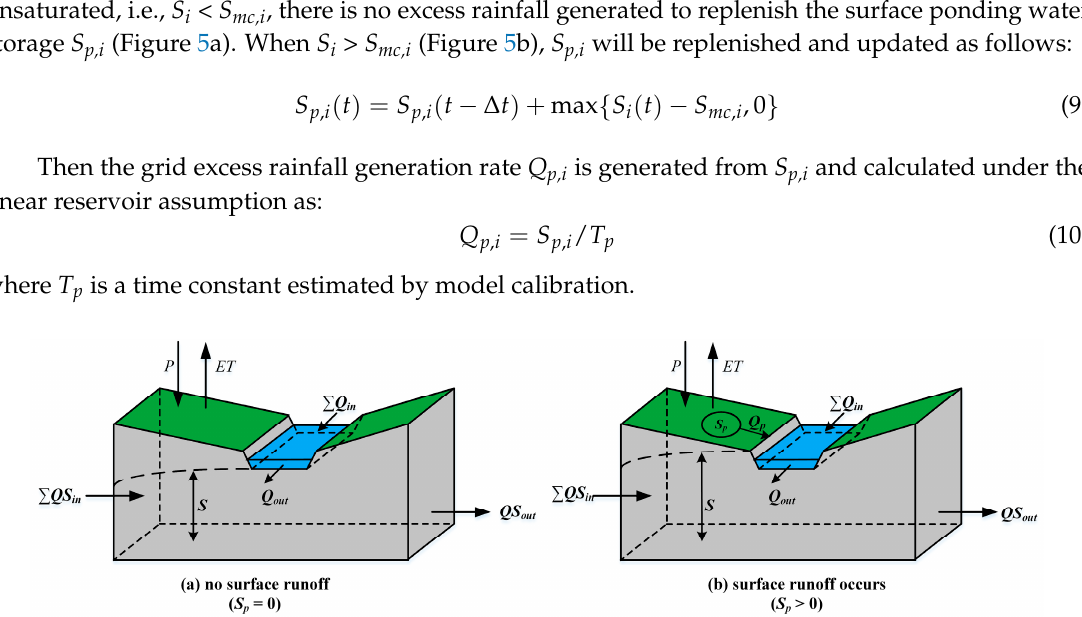
Figure 5. Hydrological processes involved in a grid where there is no excess rainfall generation ( a ) and a grid where there is the excess rainfall generation ( b ), and streamflow movement across both kinds of grids in DDRM.